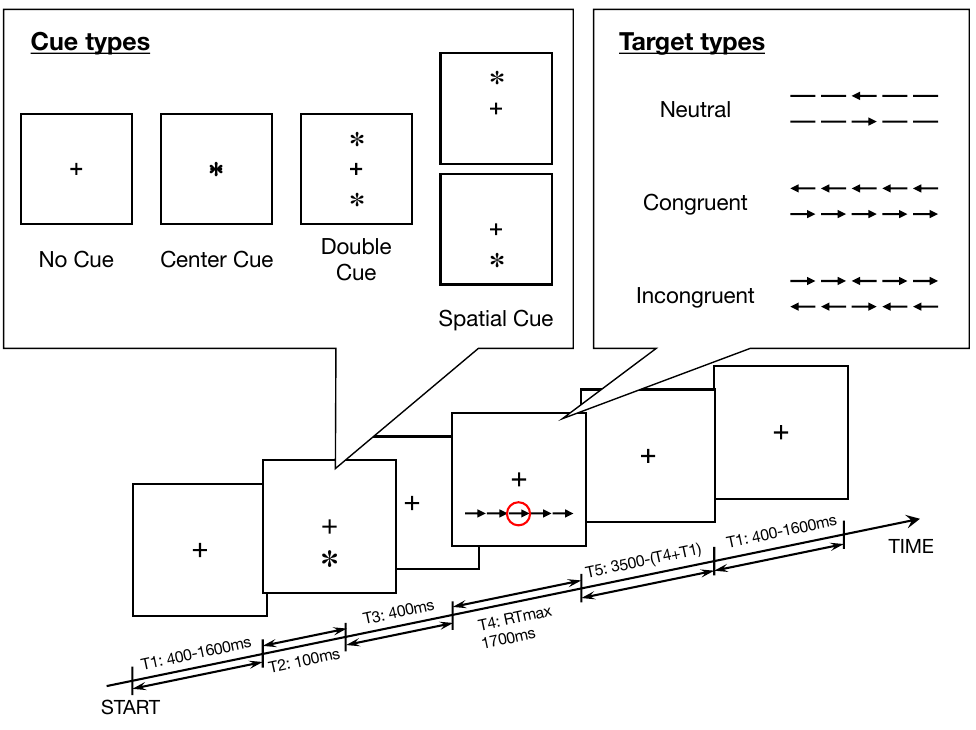
Figure 1. Experimental procedure of the Attention Network Task (ANT). The steps in a trial are summarized as follows: (T1) The participant is requested to fix a cross at the center of the screen for a random interval in the range 400–1600 ms. (T2) A cue appears for 100 ms, in the upper window, the four cue conditions. (T3) The cue disappears. (T4) A target stimulus with flankers appears, marked in the red circle in this figure; the related panel shows the six stimuli used in the present experiment. The participant is requested to select as quickly as possible the button corresponding to the direction of the target stimulus. In this example, the correct choice is to press the right button of the computer mouse. (T5) A final interval with participant’s gaze focused on the central cross is set until the next trial is